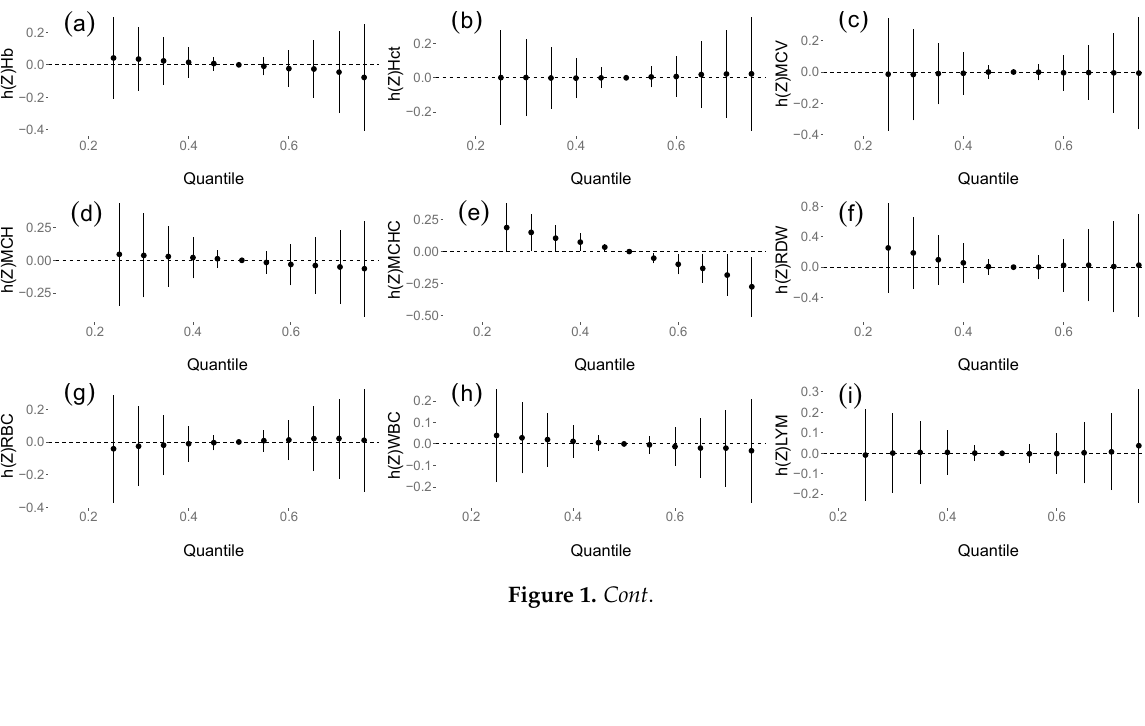
Figure 1. Overall effect (95% CI) of exposure to the insecticide mixture on haemoglobin (Hb) ( a ), haematocrit (Hct) ( b ), mean corpuscular volume (MCV) ( c ), mean corpuscular haemoglobin (MCH) ( d ), mean corpuscular haemoglobin concentration (MCHC) ( e ), red cell distribution width (RDW) ( f ), red blood cell (RBC) count ( g ), white blood cell (WBC) count ( h ), lymphocyte (LYM) ( i ), neutro- phil (NEU) ( j ), eosinophil (EOS) ( k ), monocyte (Mono) ( l ) and platelet (PLT) count ( m ) determined by the Bayesian kernel machine regression (BKMR) model when the concentrations of all the com- pound and their metabolites were at a particular percentile compared with when the concentrations of all the compound and their metabolites were at the 50th percentile. The models were adjusted for age, ethnicity, education, individual income, smoking status, alcohol consumption, body mass in- dex (BMI), work and exposure characteristics, behaviour during and after working, food consump- tion and food items consumed in the past month. 3.5. Sensitivity Analysis The results from the BKMR model were confirmed by GLM analysis. The association between urinary concentrations of CLO and MCHC determined by GLM is provided in Table 4. The GLM also showed a negative association between CLO and MCHC (see also Figures S1 and